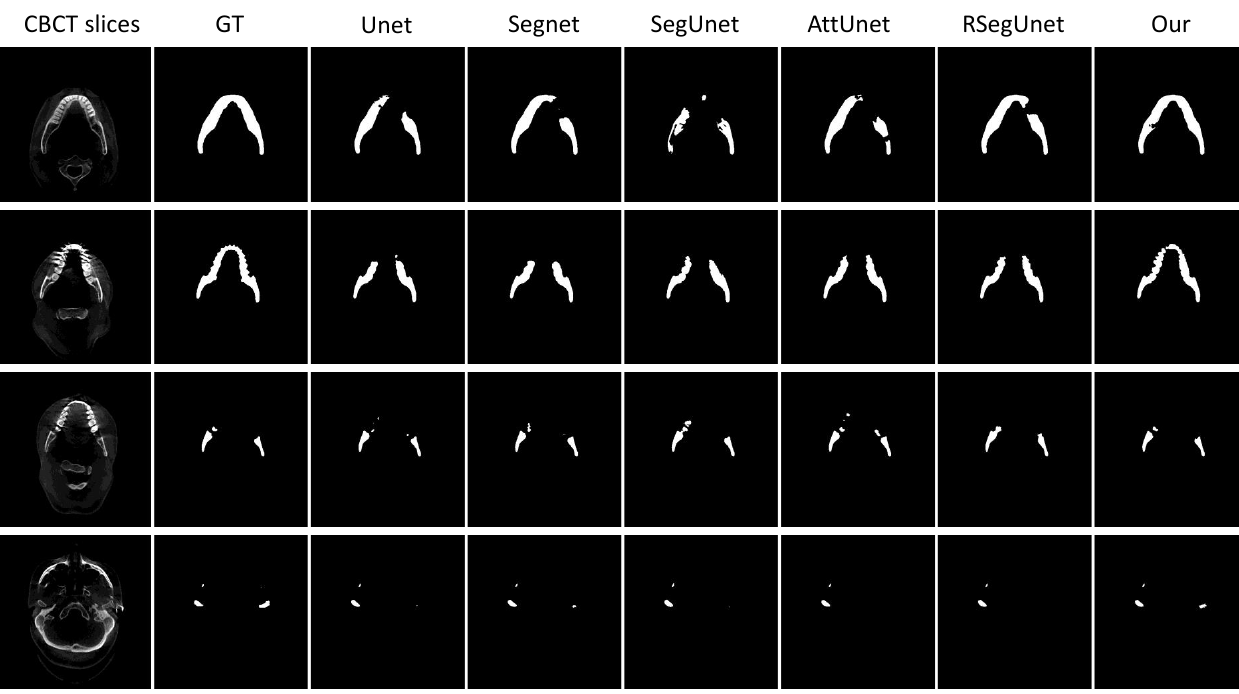
Figure 4. 2D examples from CBCT dataset. From left to right: Original CT slice, Ground truth (GT), Unet, Segnet, SegUnet, AttUnet, RSegUnet, and the proposed